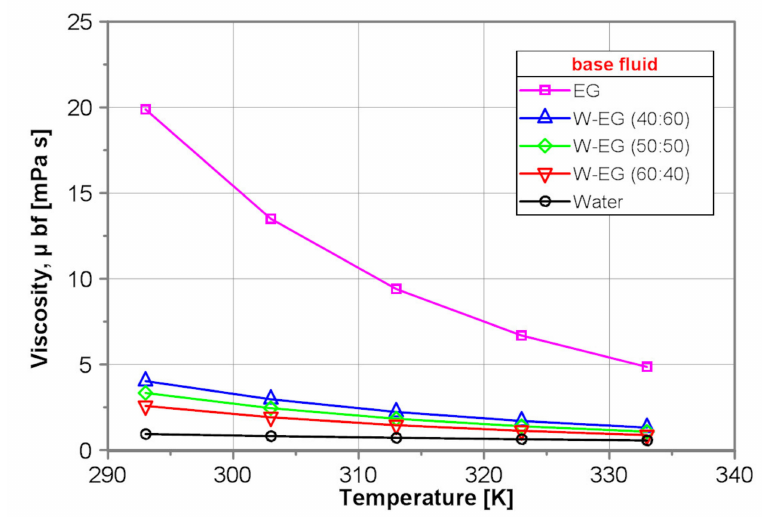
Figure 2. Dynamic viscosity of the tested base fluids.